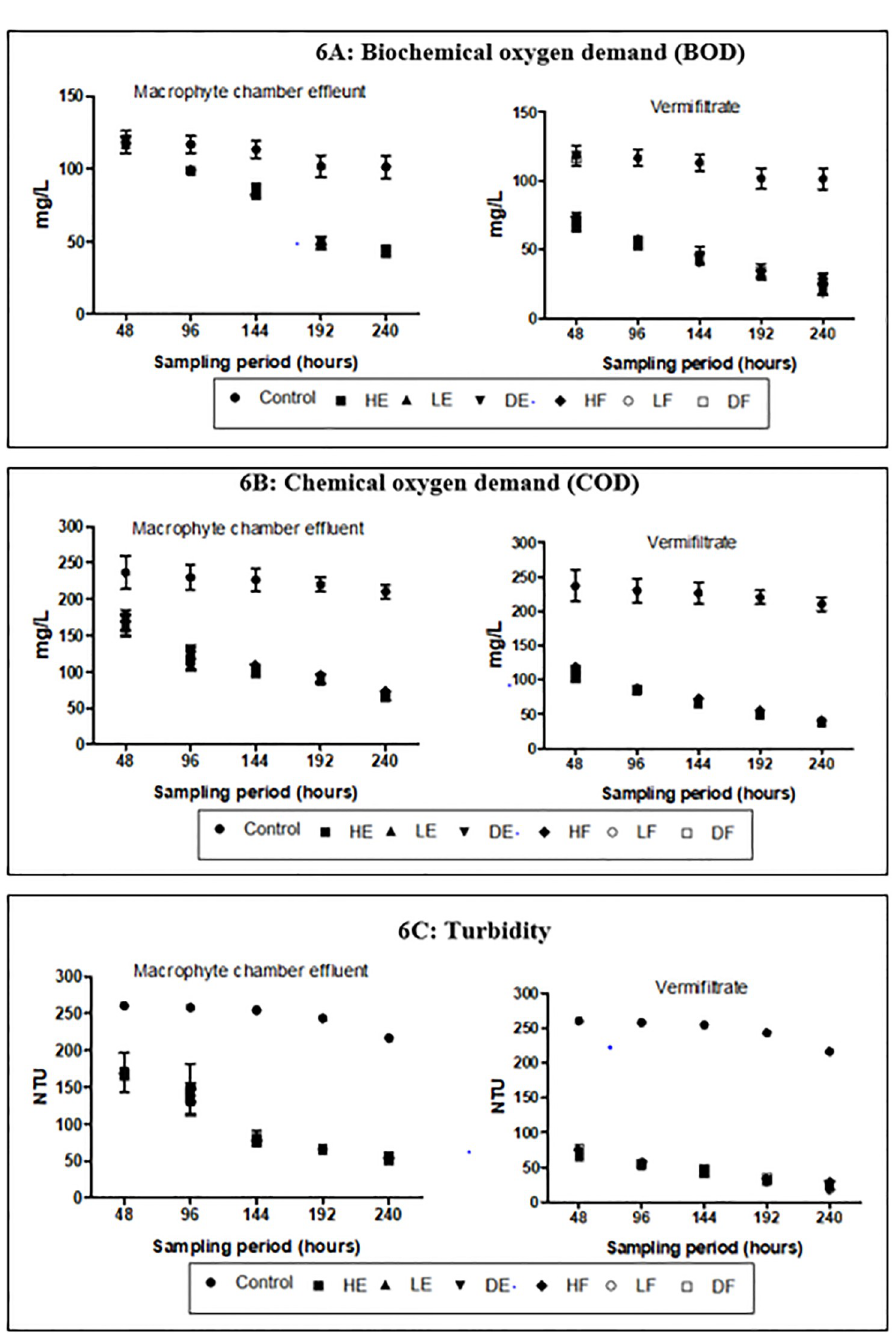
Fig 6. Physicochemical characteristics of effluent (A) BOD (B) COD (C) Turbidity (D) DOC.